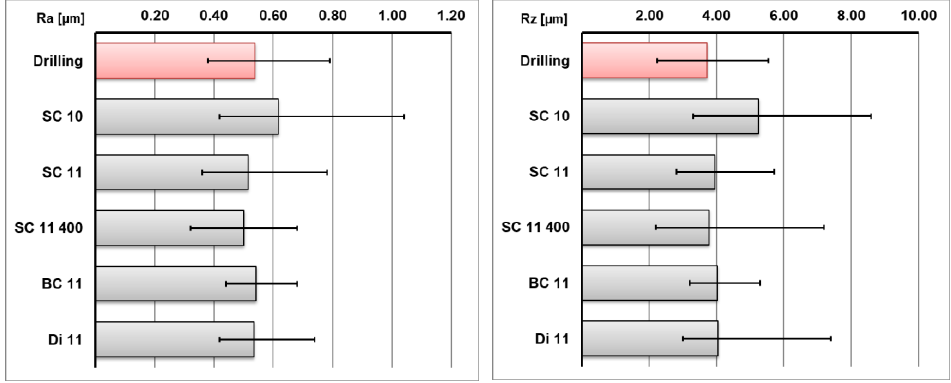
Figure 4. Ra [µm] and Rz [µm] roughness values after drilling and finishing Inconel 718.